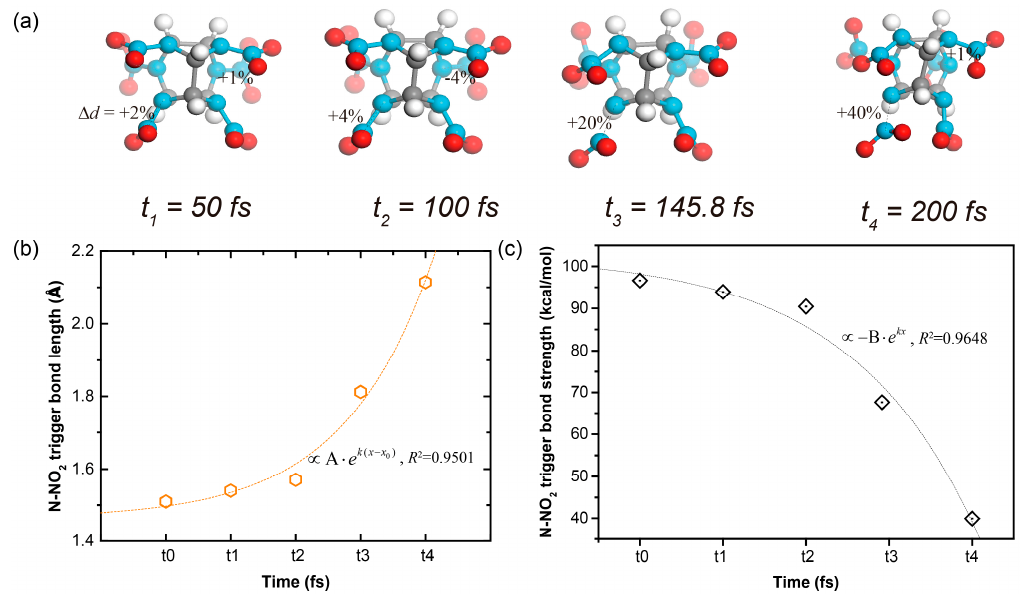
Figure 3. ( a ) Conformation vs time plots for a molecule in the shocked ε -CL-20 crystal, along with the corresponding ( b ) length and ( c ) strength of the trigger bond N–NO 2 in each snapshot of ( a ).